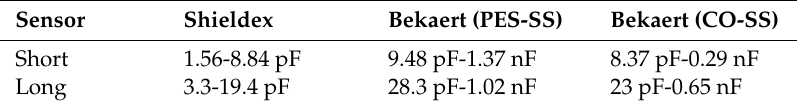
Table 4. Measured sensors capacitance ranges at 2 kHz.